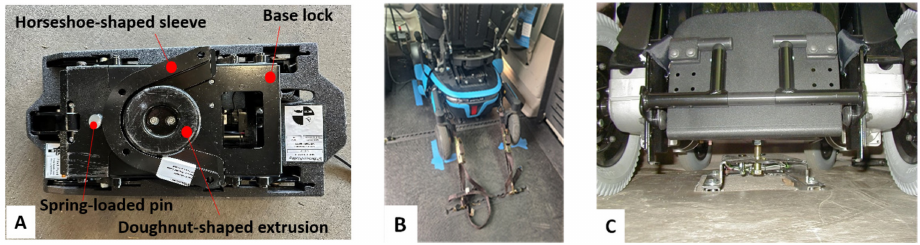
Figure 1. ( A ) QLX WDS, ( B ) 4-point tiedown system, ( C ) EZ-Lock.